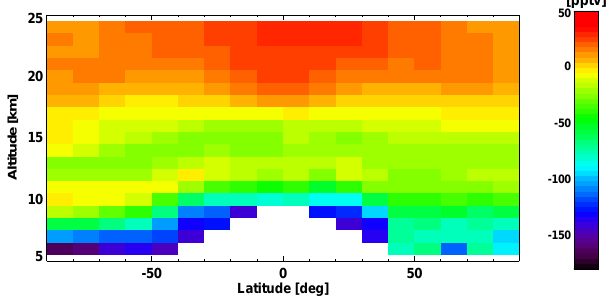
Figure 6. Bias correction applied to the MIPAS data set from period P2